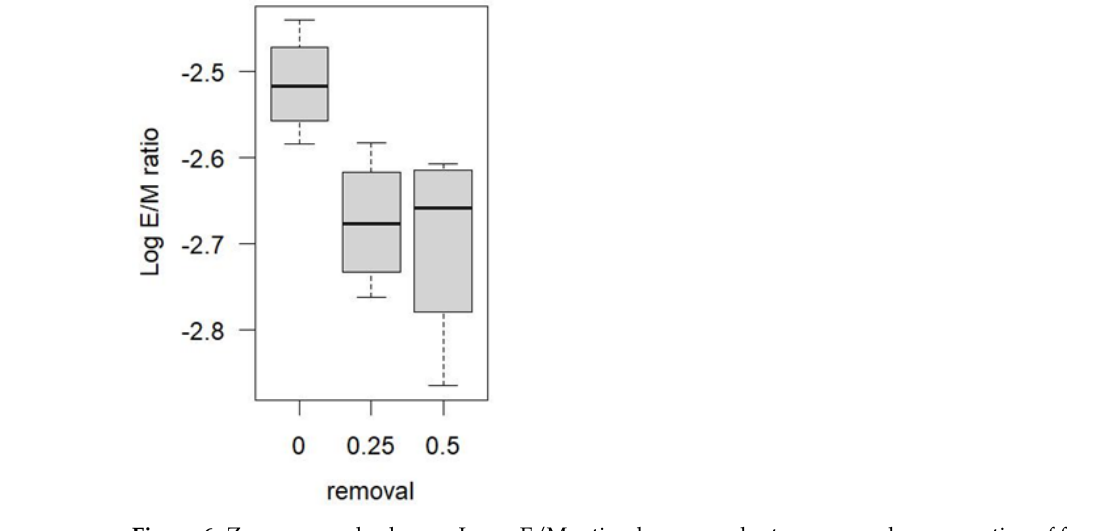
Figure 6. Zama spruce budworm Log 10 E/M ratios, by removal rate, measured as proportion of forest removed (0 signifies unharvested blocks). Years of potential heavy immigration (1999, 2000, 2009) were removed from analysis. (Log transformation was used to stabilize variances among years.). Table 2. Results from ANOVA of spruce budworm E/M ratio 1997–2011, against year and forest removal rate, excluding years of potentially heavy immigration from afar: 1999, 2000, and